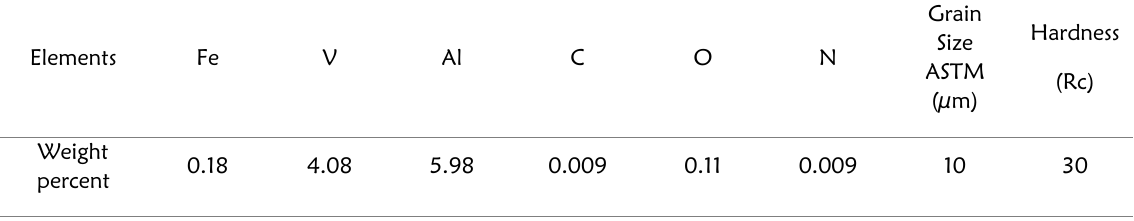
Table 1: Typical chemical composition Ti6Al4V, grain size and